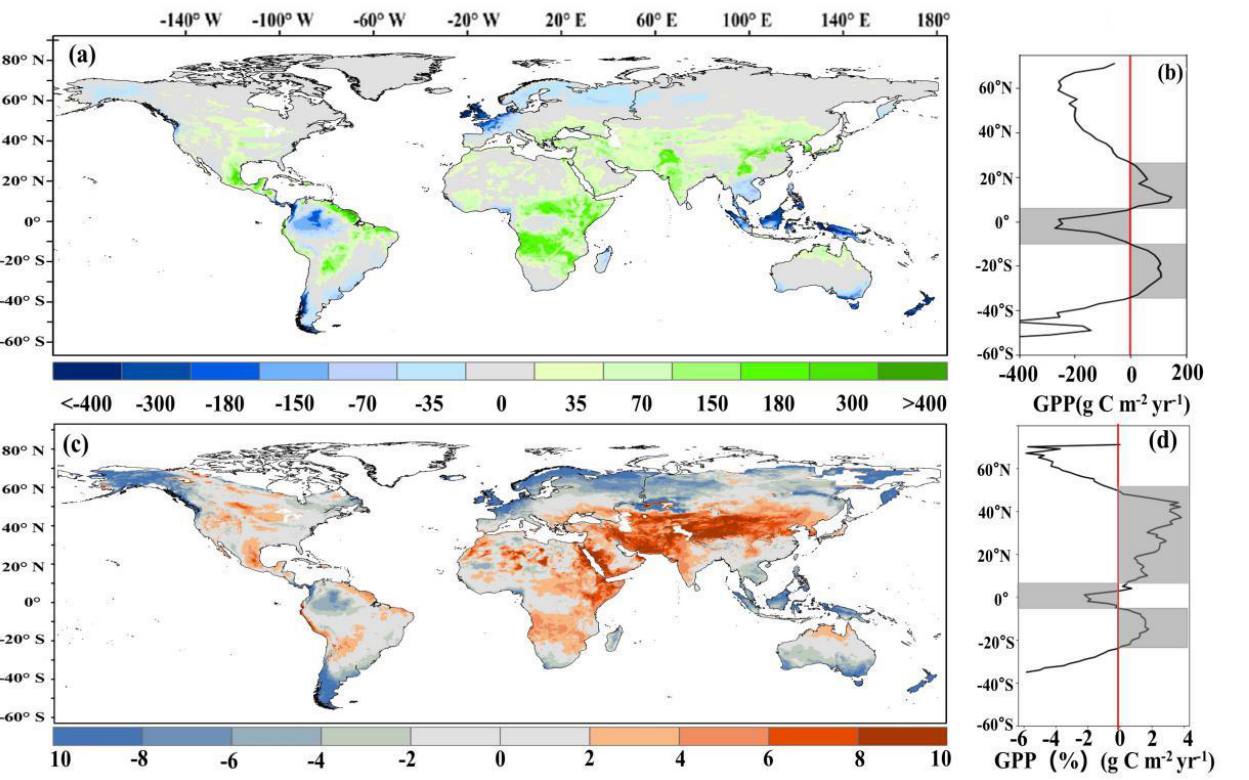
Figure 6. The spatial distribution of aerosol effects on global ( a ) ΔGPP (g C m − 2 yr − 1 ) and the variation of its annual ( b ) latitude from 2000 to 2019.The percentage changes in the spatial distribution of ( c ) ΔGPP (%) (GPP( AOD-LUE) − GPP(EC-LUE)/GPP(EC-LUE) × 100) caused by aerosols and the variation of its ( d ) latitude from 2000 to 2019.